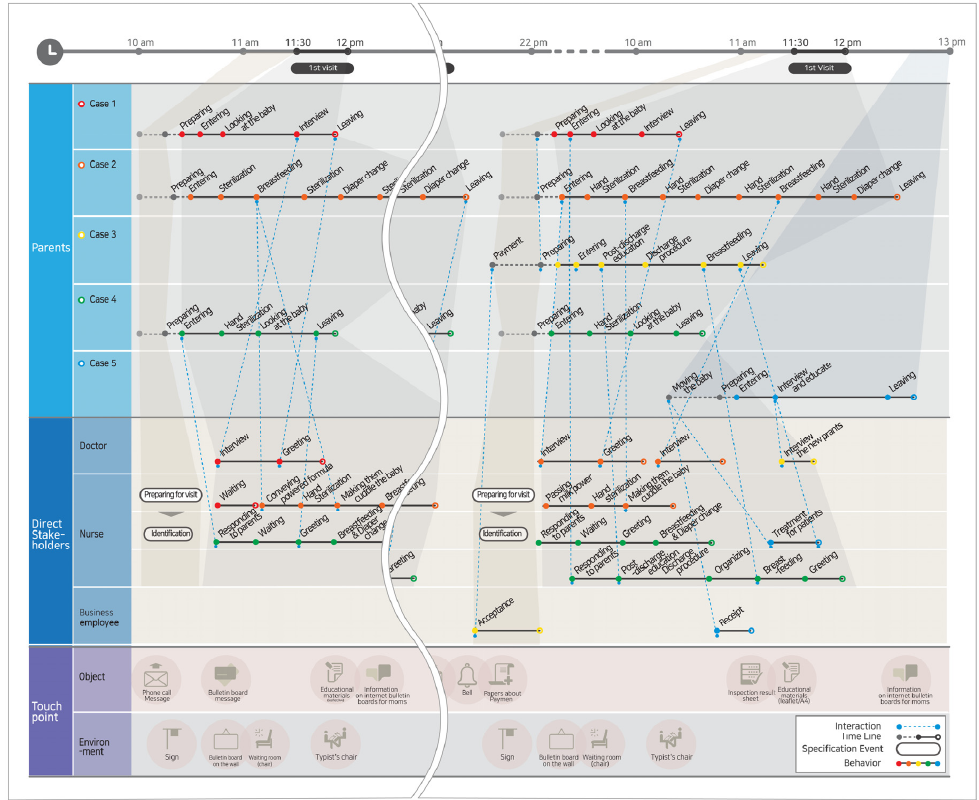
Figure 2. Customer journey map: A map showing the entire process of experiencing the NICU’s services so that parents can understand who they are meeting, what they are doing, and what interactions and contact points they should expect.